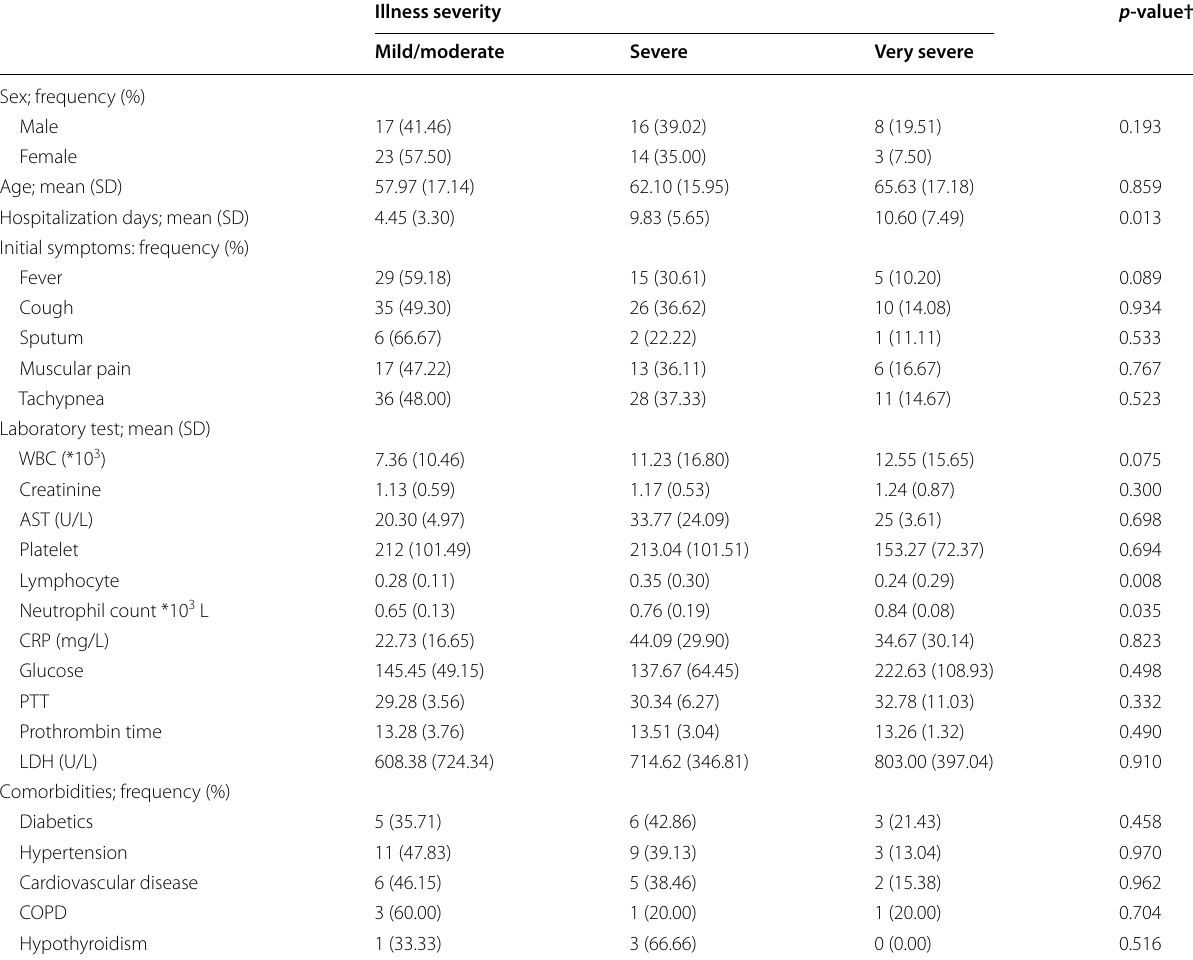
† p ‑value from Pearson’s chi‑squared test statistics and one‑way ANOVA between illness severity and clinical and demographic characteristics. WBC white blood cell counts, AST aspartate aminotransferase, CRP C‑reactive protein, LDH lactate dehydrogenase, COPD chronic obstructive pulmonary